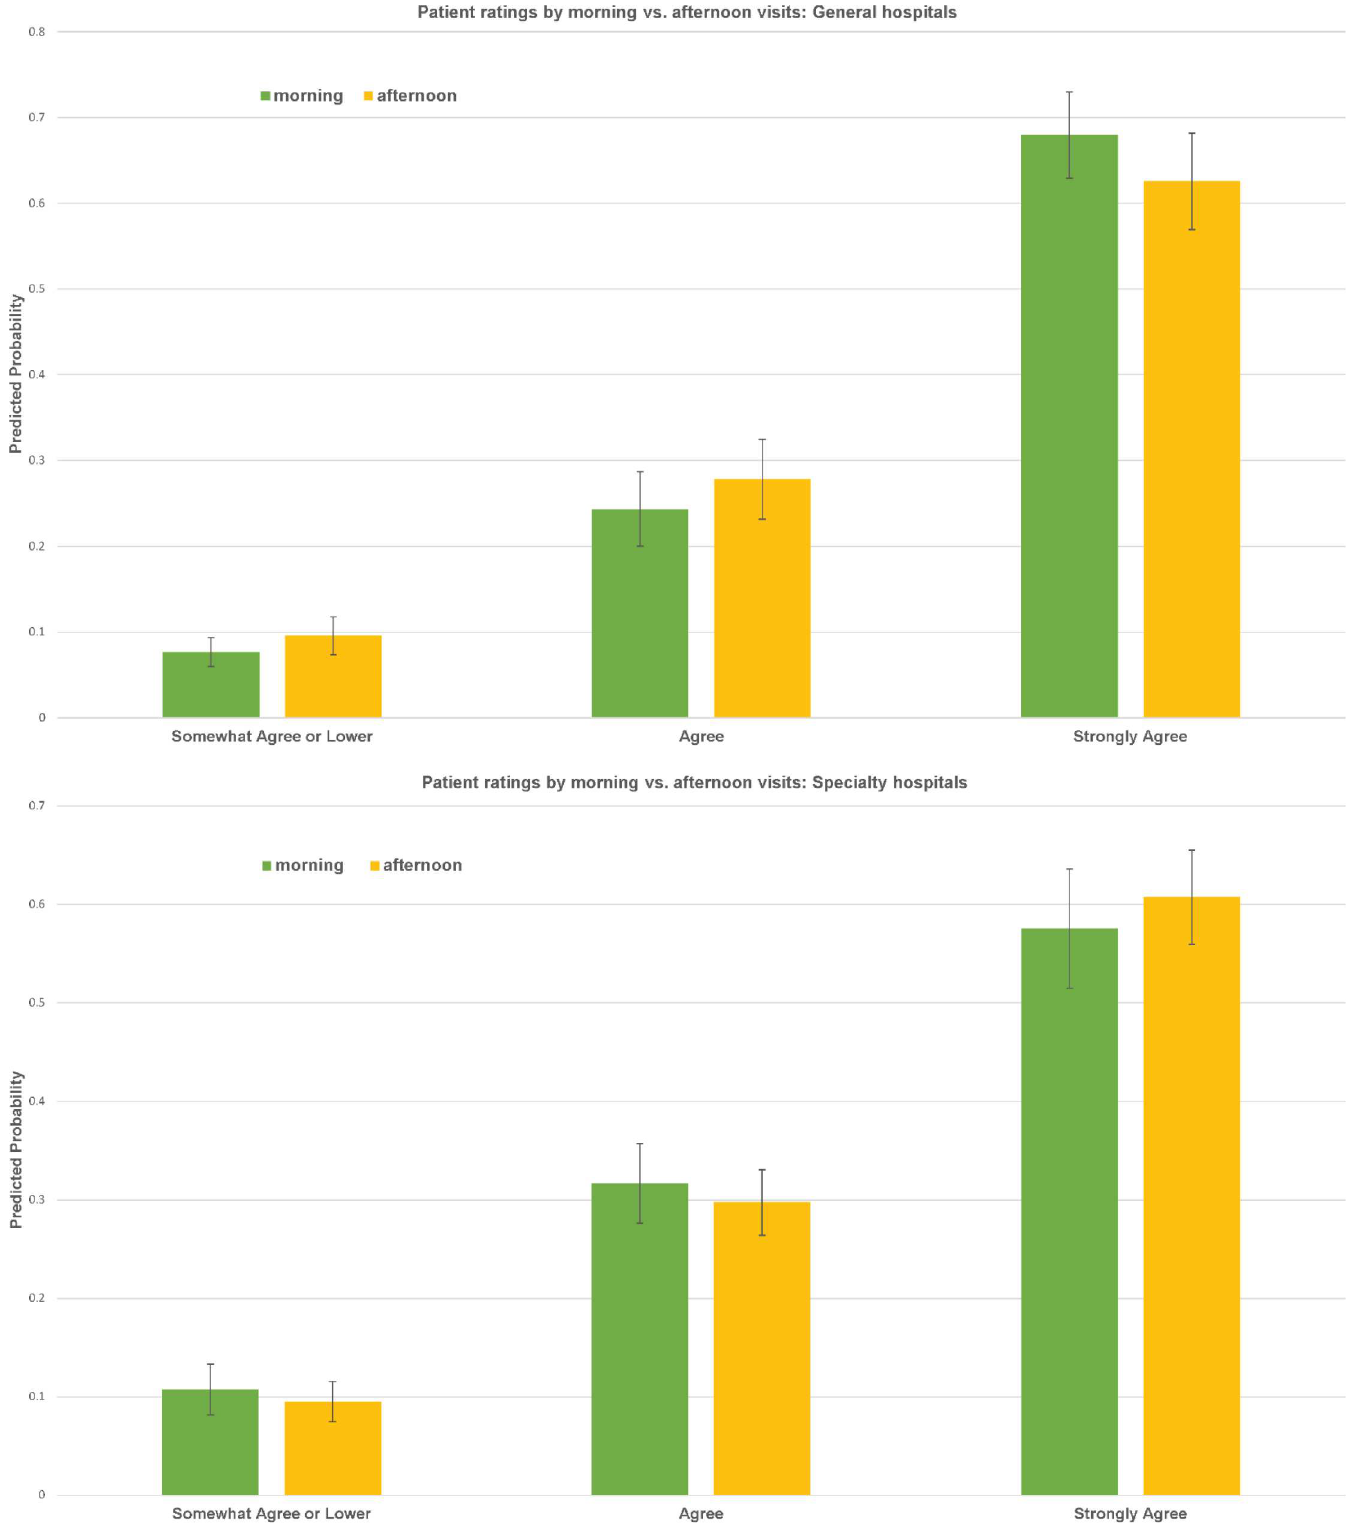
Fig 3. Patient ratings by morning vs. afternoon visits. (A) Generalhospitals.(B) Specialty hospitals.